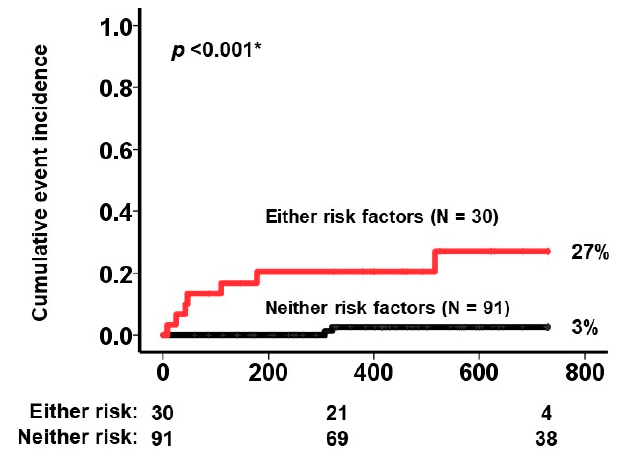
Figure 1. Cumulative incidence of the composite primary endpoint stratified by the existence of three risk factors (either one versus neither one). Risk factors consist of heart failure, coronary disease, and the use of 0.1 mg/day of pemafibrate. Both curves were compared by log-rank test. * p < 0.05. Table 4. The lipid parameters at 3-month follow-up stratified by experiencing an adverse cardiovas- cular